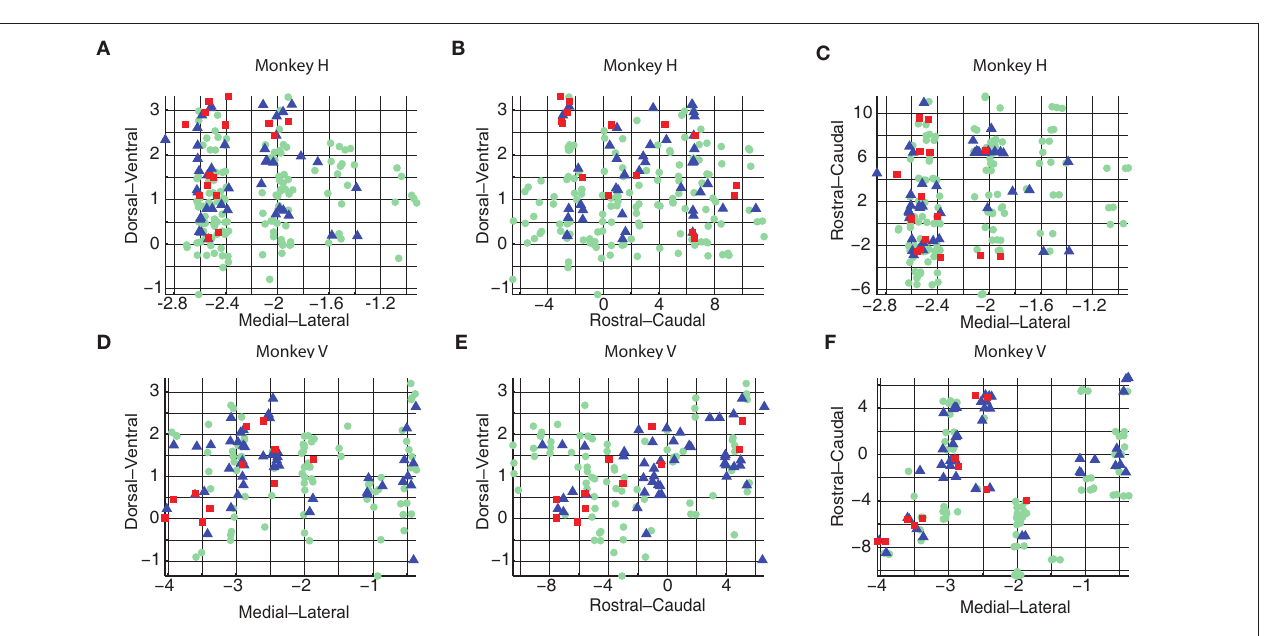
Figure 4 | Cluster distribution types computed by the AVPSD method. Data for monkey H ( A–C ) and monkey V ( D–F ) is presented in different planes: Dorsoventral–Mediolateral ( A,D ), Dorsoventral–Rostrocaudal ( B,e ), and Rostrocaudal–Mediolateral ( C,F ).